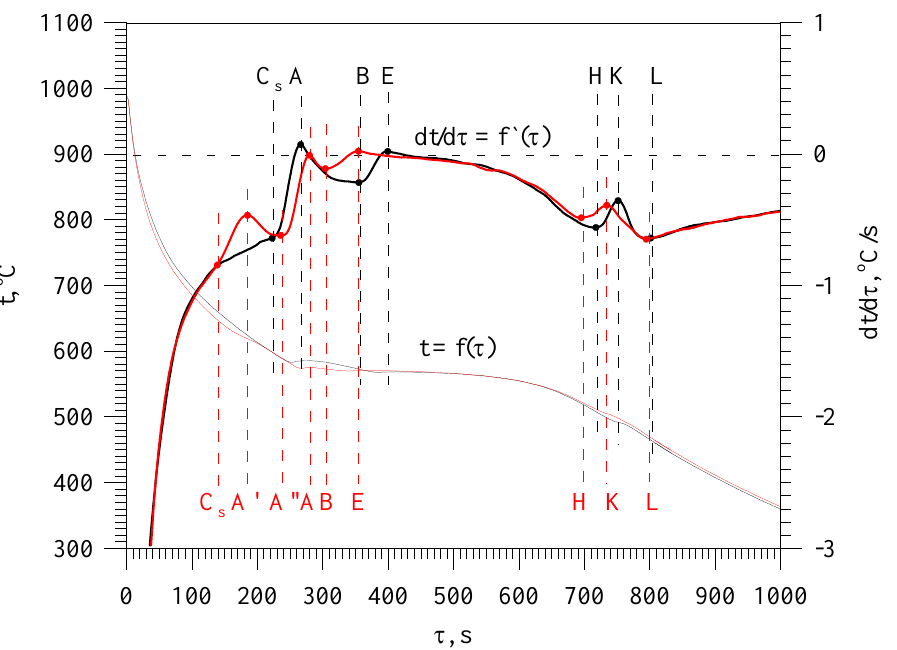
Figure 1. Thermal and derivative analysis curves of the base alloy (black color) and containing 0.20 wt % Cr, Mo, V, and W (red color).